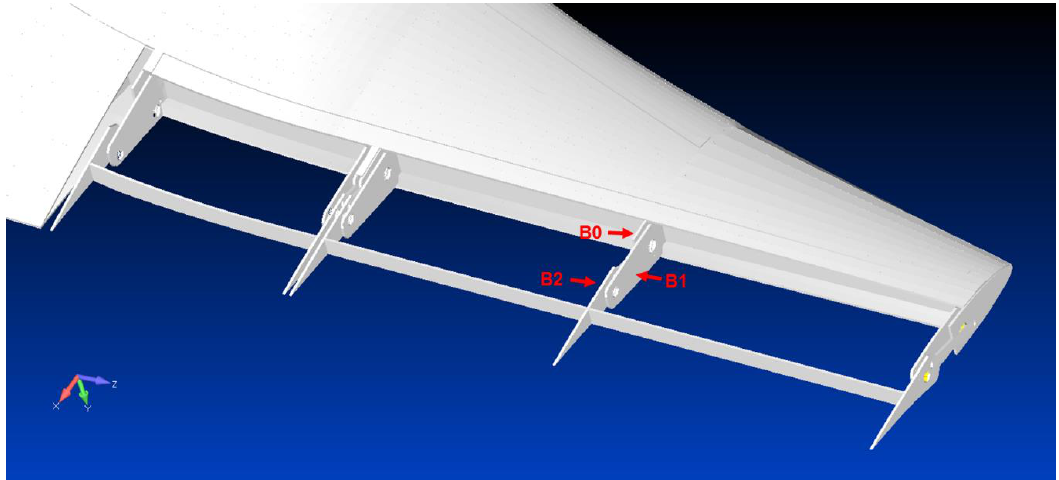
Figure 2. Finger-like mechanism of the morphing winglet trailing edge.